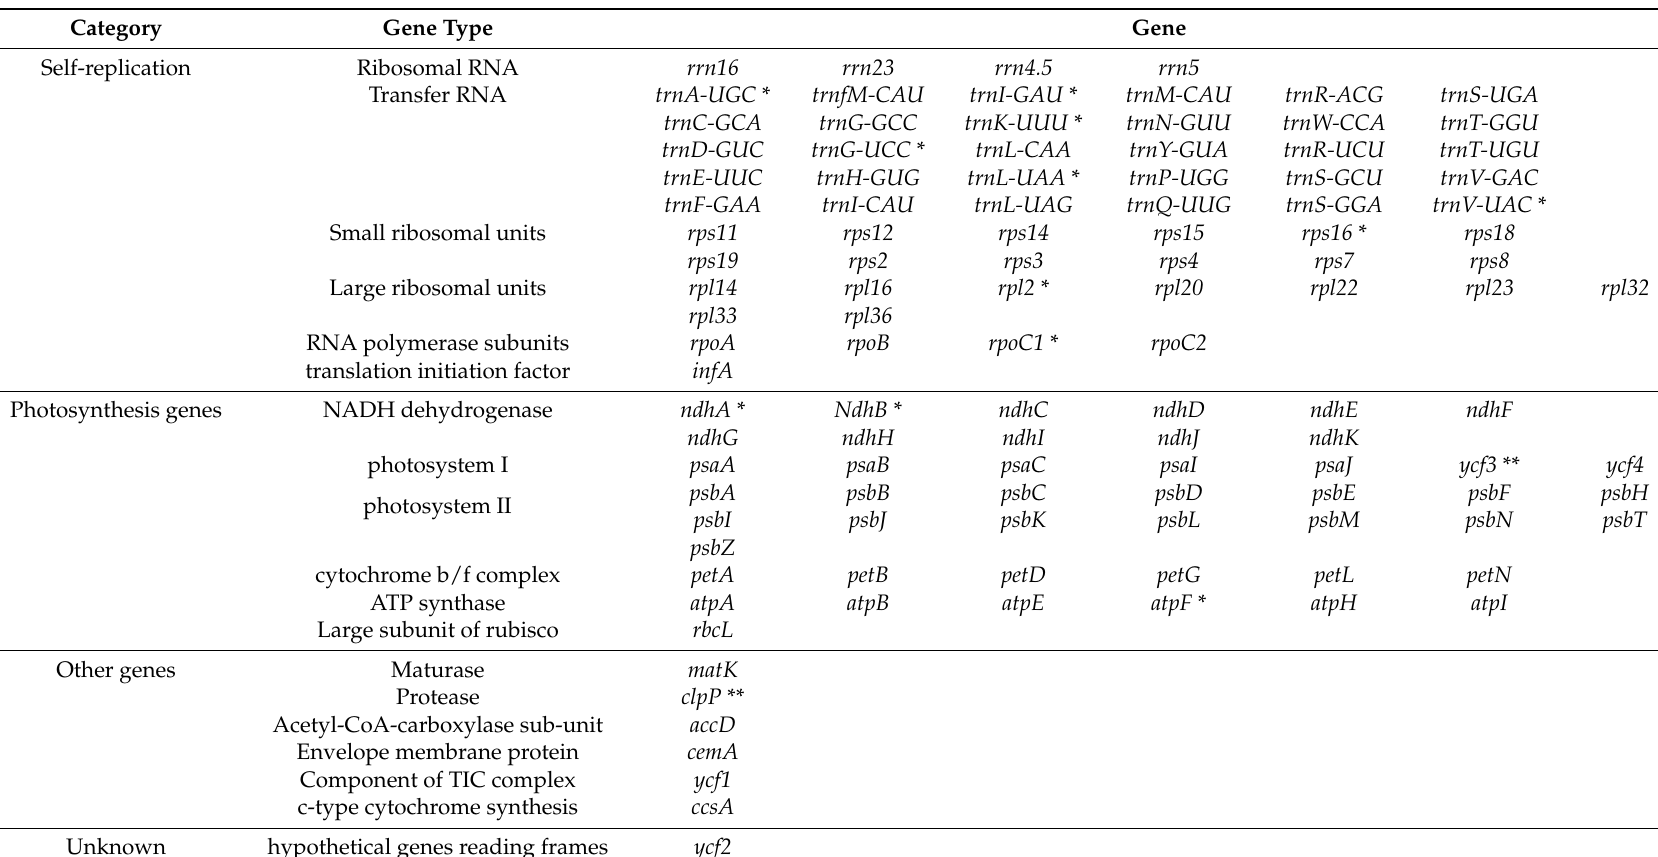
Table 2. List of genes encoded in each of the five chloroplast genomes of